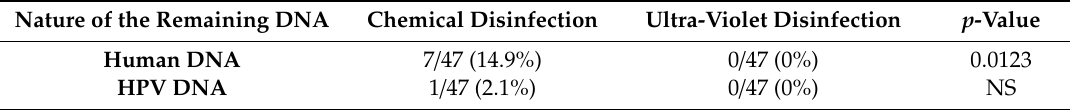
Table 2. Comparison of chemical and ultraviolet disinfection. HPV-DNA found on one probe was positive with high-risk HPV 51 DNA. The di ff erence was not statistically significant (NS) for HPV DNA but was significant for human DNA ( p <